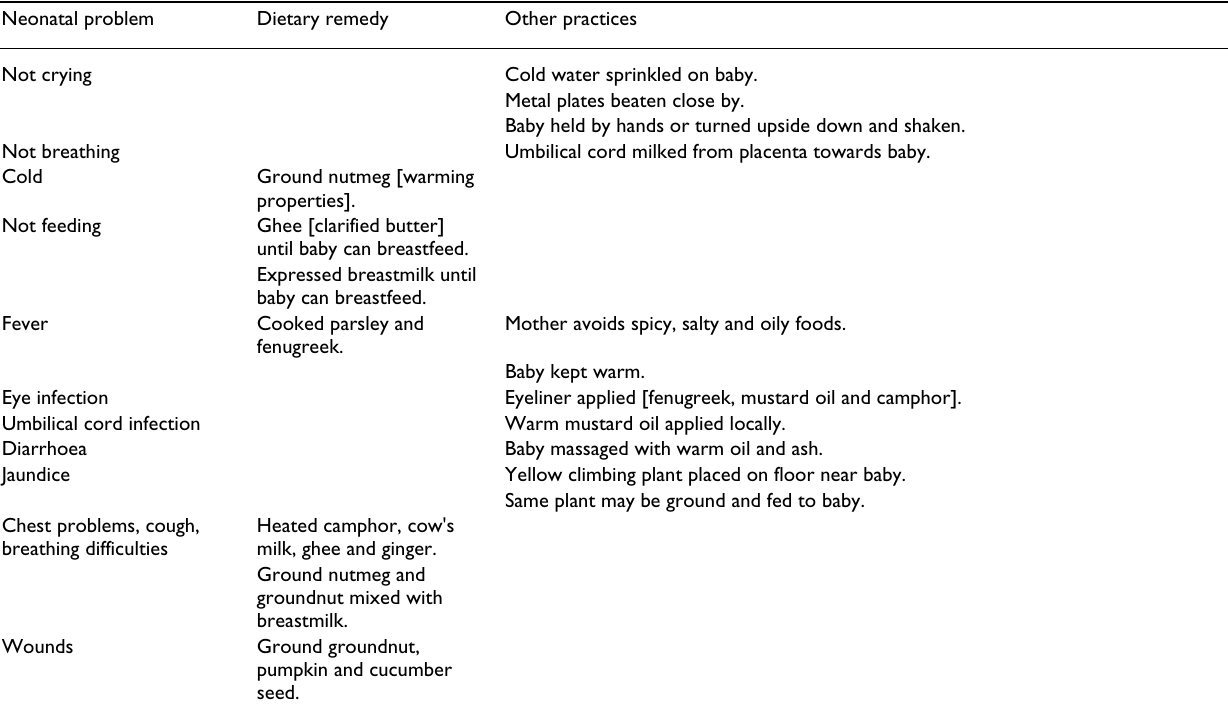
Table 6: Home care practices for neonatal problems suggested in focus group discussions Neonatal